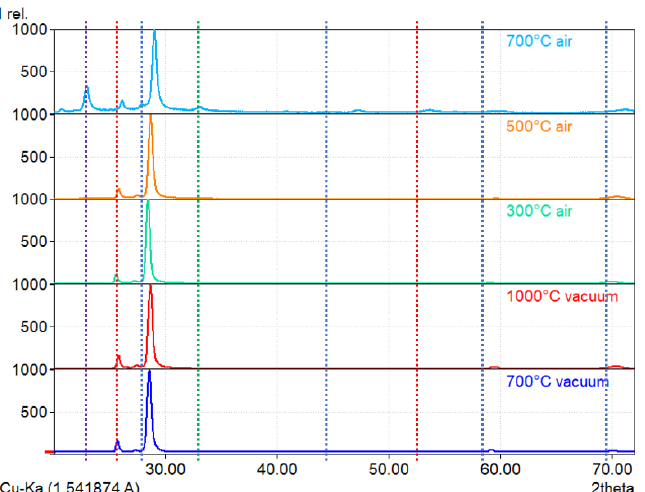
Figure 5. X-ray diffraction patterns of coatings treated in air at 300 °C, 500 °C, and 700 °C and in vacuum at 700 °C and 1000 °C. WB 2 – P6/mmm marked with a blue dashed line, WB 2 – P63/mmc marked with a red dashed line, B 2 O 3 marked with a green dashed line, and WO 3 marked with a purple dashed line.